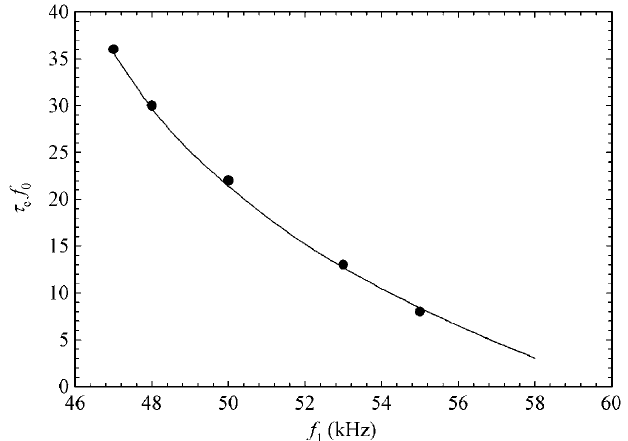
FIG. 11. The values of (cid:9) extracted from the data in Fig. 9 are c plotted together with a curve derived from solving the equation that results from demanding that the maximum smooth-focusing vacuum phase advance that occurs during the transition equal the maximum value for single-particle orbit stability 115.6 (cid:4) .